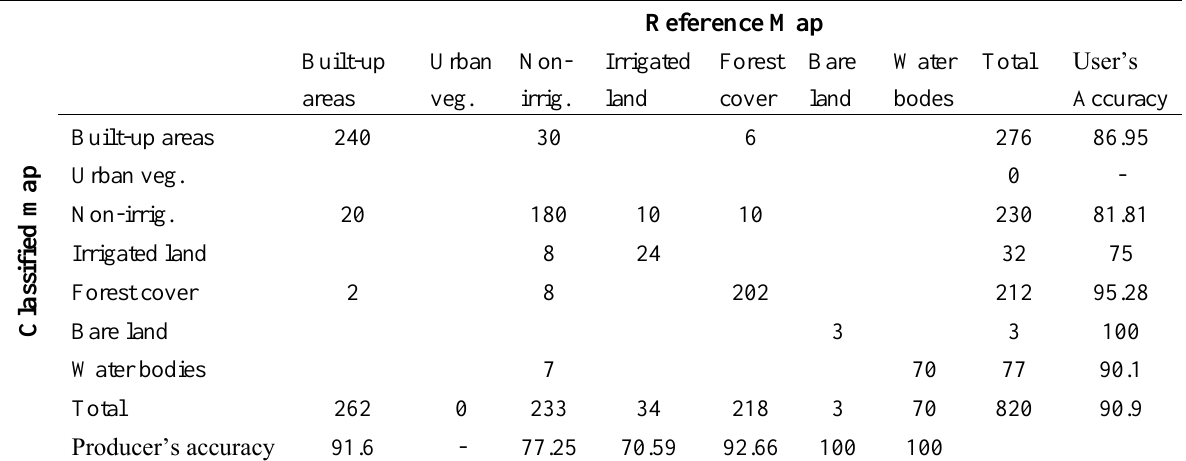
Table 5. Error matrix (%): image classification of